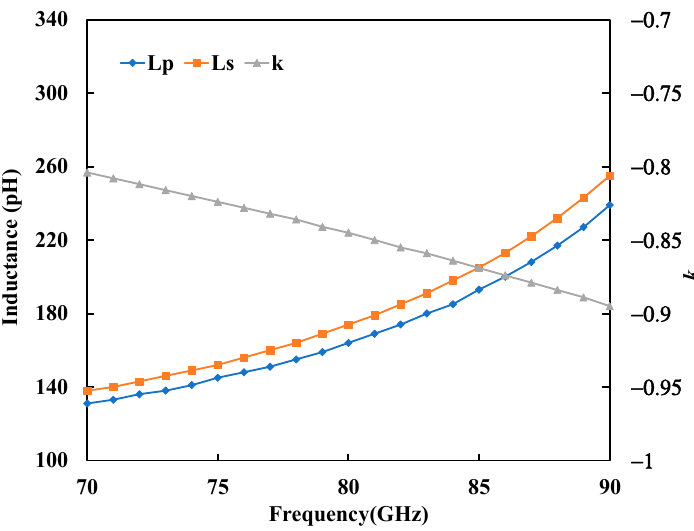
Figure 10. The simulated inductances of the primary and secondary windings and the coupling